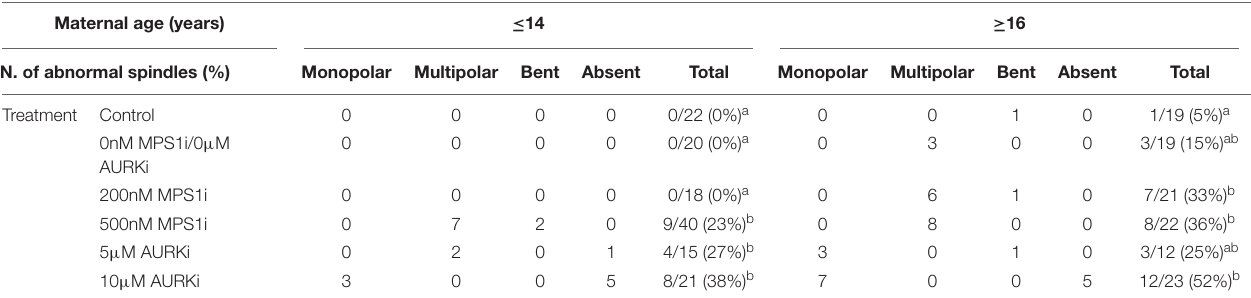
TABLE 2 | Number, type and frequency of spindle abnormalities in MII oocytes from young ( ≤ 14 years) and old ( ≥ 16 years) mares, treated with MPS1i (0, 200, or 500 nM) or AURKi (0, 5, or 10 µ M) after Nocodazole washout. Maternal age (years) ≤ 14 ≥ 16 N. of abnormal spindles (%)